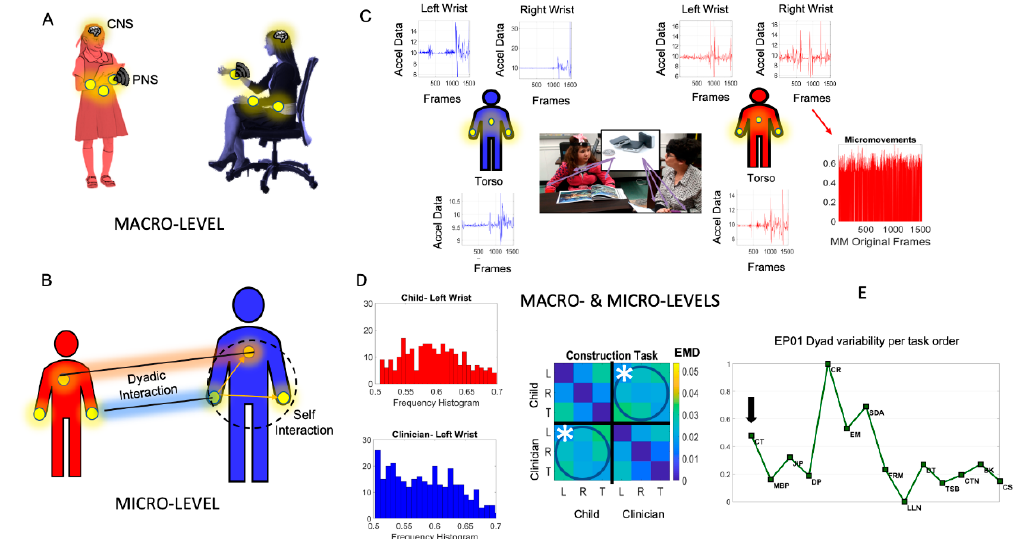
Figure 1. Leveraging the wearable sensors revolution to significantly augment traditional pencil and paper methods and advance the behavioral sciences. ( A ) The macro-level of behavioral description inevitably misses fast and subtle information in dyadic social interactions, as information flows between the Central and the Peripheral Nervous Systems (the CNS and the PNS). ( B ) Micro-level coherence information, automatic social mirroring, lead-lag patterns, and micro-gestures of the face and body, among other socio-motor behaviors, can only be captured with high grade instrumentation and proper analytics. ( C ) Macro- and micro-levels of inquiry can be integrated to advance social behavioral sciences, e.g., the Autism Diagnostic Observation Schedule (ADOS) is used as a backdrop experimental assay to probe dyadic social interactions, combined with wearables. to digitize standard clinical criteria. Light wearables embedded in the clothing unobtrusively and continuously co-register child and clinician (certified as rater) during the administration of the ADOS test to detect autism. Micro-fluctuations in the timeseries data from these wearables (e.g., acceleration waveforms) can be converted to standardized micro-movement spikes (MMS) to derive various socio-motor biometrics. ( D ) The Earth Mover’s Distance (EMD) metric is used to ascertain the pairwise difference between frequency histograms of MMS and build a matrix with entries capturing the dyadic interactions (circled entries) and the self-interactions of body nodes. ( E ) The averaged sum across all dyadic interaction entries per unit time, obtained task by task, in the order in which they were administered, gives us a session profile of the dyadic variability, as one example of several metrics used here to objectively quantify socio-motor behavior simultaneously at the macro- and micro-levels of inquiry.